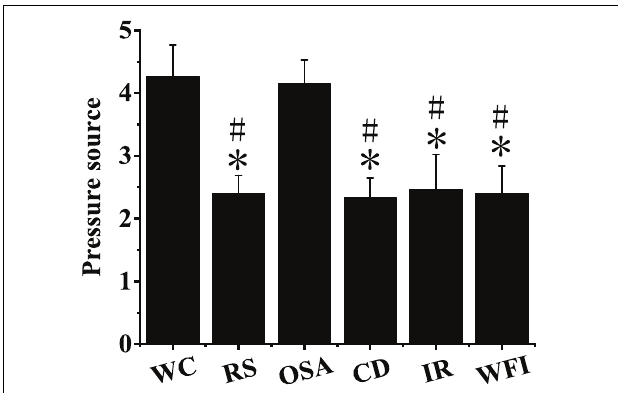
FIGURE 1 | Descriptive statistics of stress sources of employees. ∗ Indicated that the difference was notable compared with work characteristics